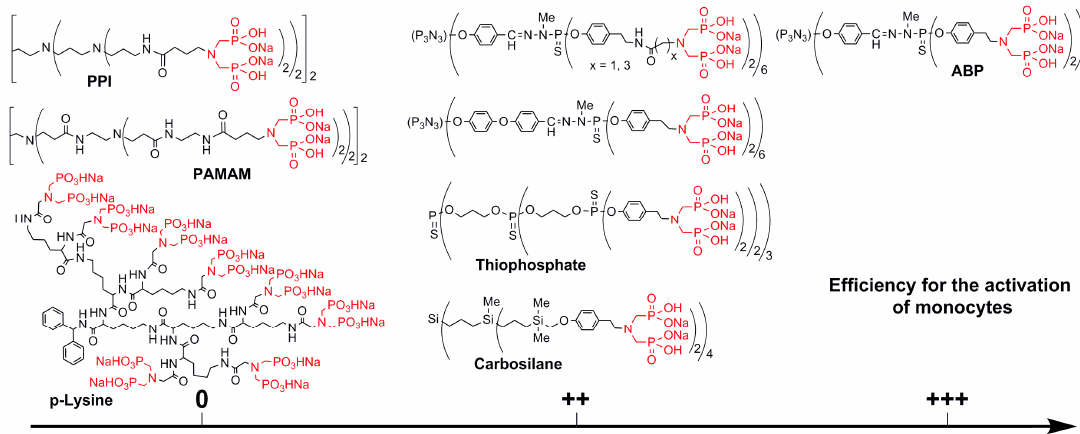
Figure 4. Efficiency of the activation of monocytes, depending on the internal structure of the dendrimers (0: no activation; ++: good activation; +++: the highest activation).